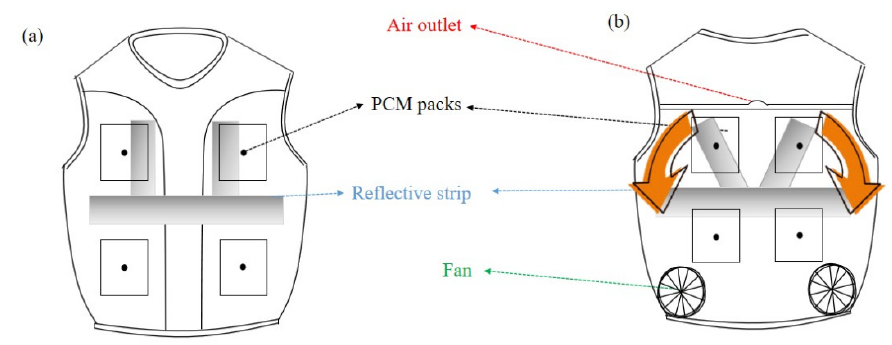
Figure 1. Illustration of the personal cooling vest (PCV): ( a ) front view; ( b ) back view.